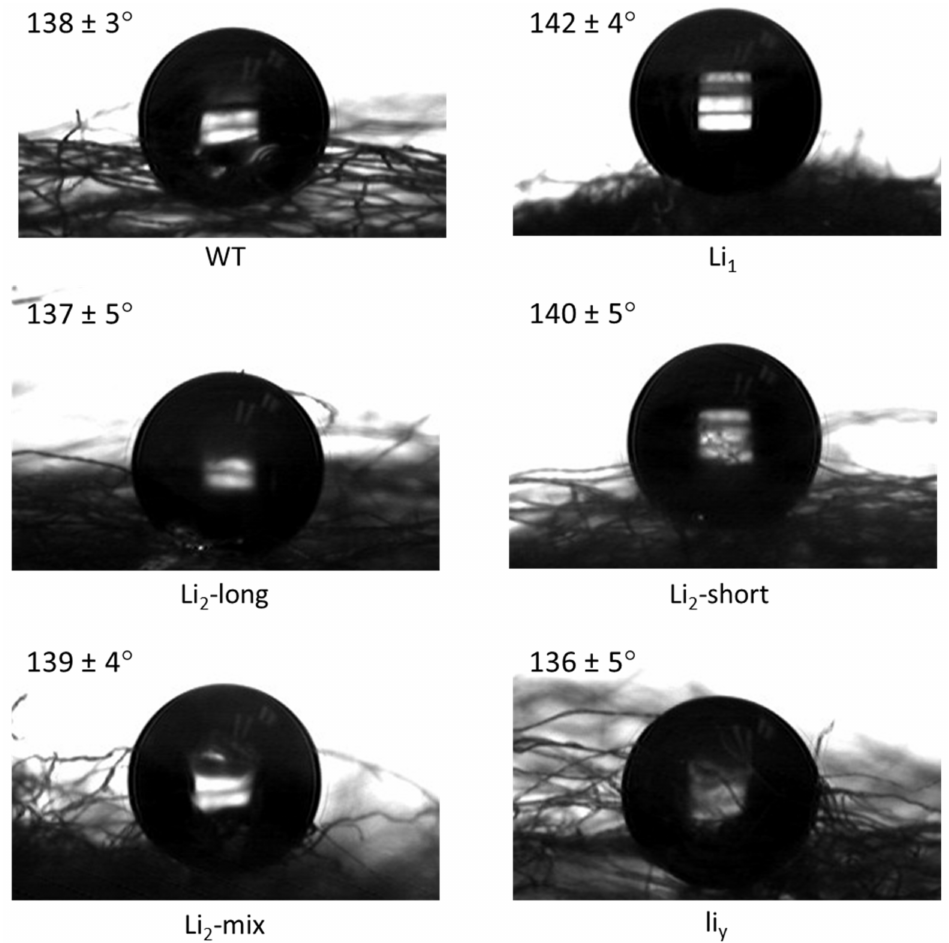
Figure 6. Water droplets on the fiber webs. The values at each image are the contact angle with standard deviation ( n = 5). No statistically significant difference ( p > 0.05) was observed between these